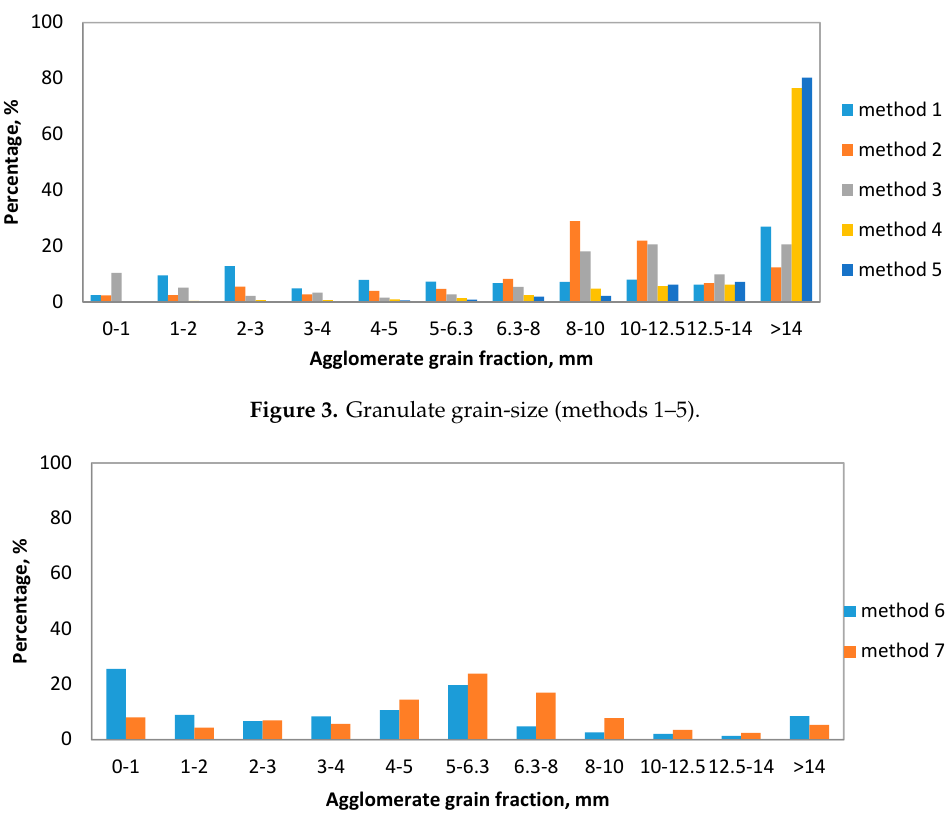
Figure 4. Granulate grain-size (methods 6–7).